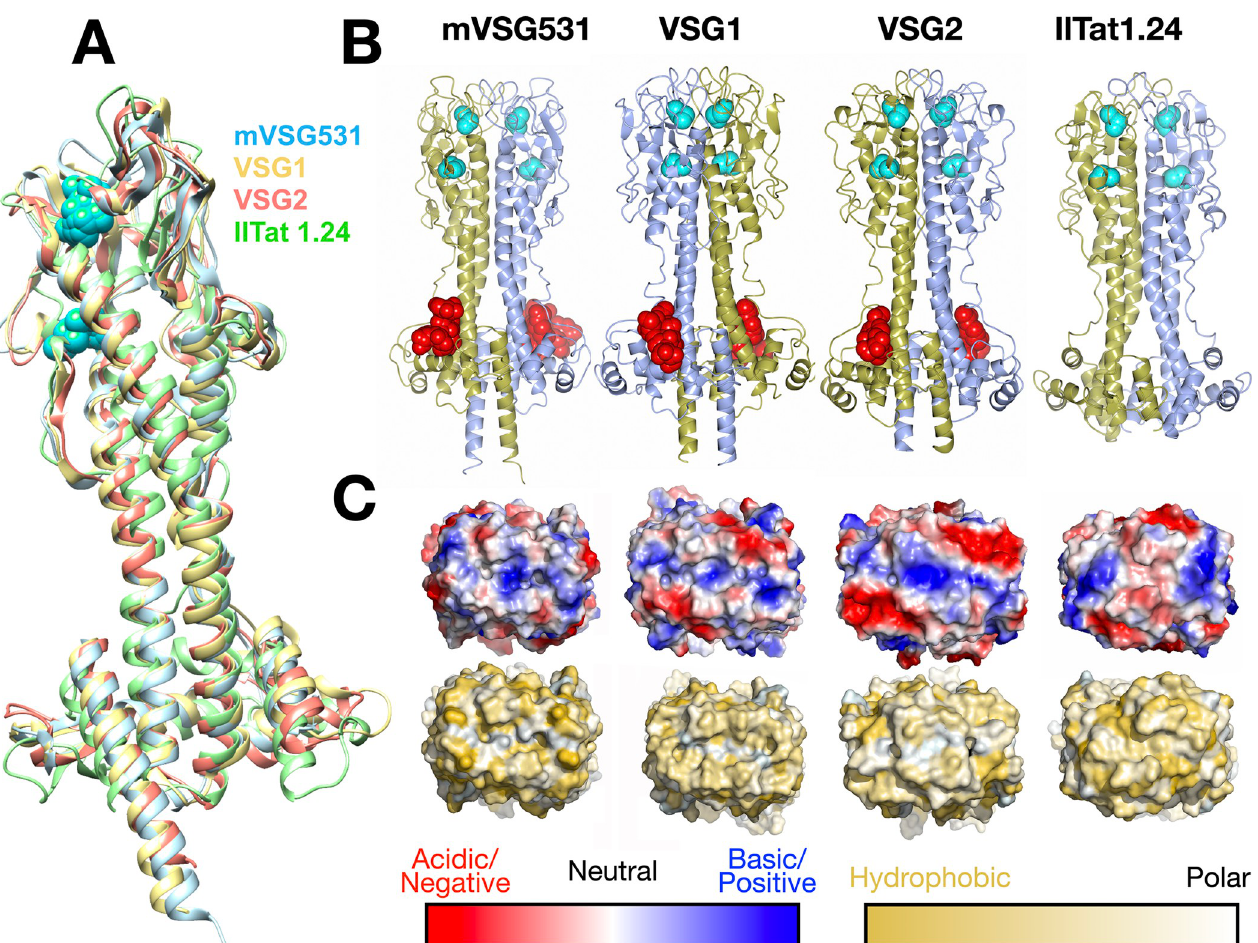
Fig 3. Crystal structure of mVSG531. (A) Superposition of class A2/N2 monomers of mVSG531, VSG1, VSG2, and IlTat1.24 produced using DeepAlign in the RaptorX structure alignment server [48,49].Images of protein structures were generated and edited using CHIMERA [61]. (B) Side-by-side comparison of different class A VSG dimer highlighting common fold, disulfide placement (cyan spheres), and N-linked glycan (red spheres). Structures drawn with CCP4 mg [57]. (C) 90-degree rotation of the structures in (B) to view the “top” surface of the VSG, rendered as a molecular surface. Top row shows the surface colored by contact potential (red indicating acidic/negatively charged, blue indicating basic/positively charged, and white neutral, all surfaces scaled identically). The bottom row is colored by the Eisenberg hydrophobicity scale [59], where yellow indicates hydrophobic and white polar. Molecular surfaces are illustrated with PyMOL